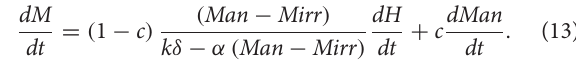
FIGURE 4 | The sketch of the piston of the MR fluid damper labeled the locations and installation of the two Hall